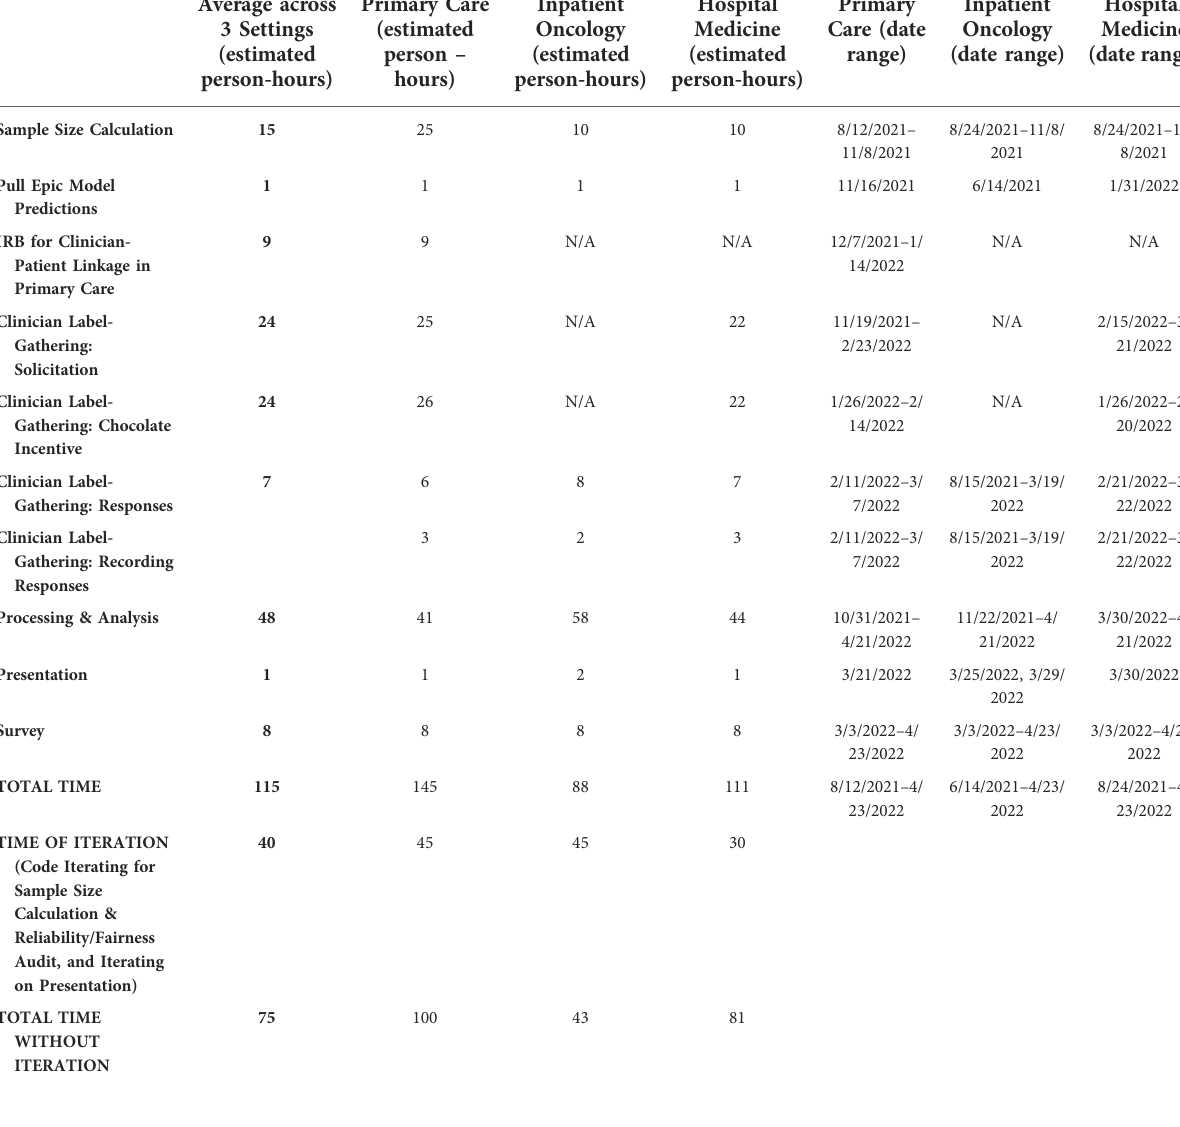
TABLE 12 Time and requirements to generate reliability and fairness audits. For further detail, see Supplementary File